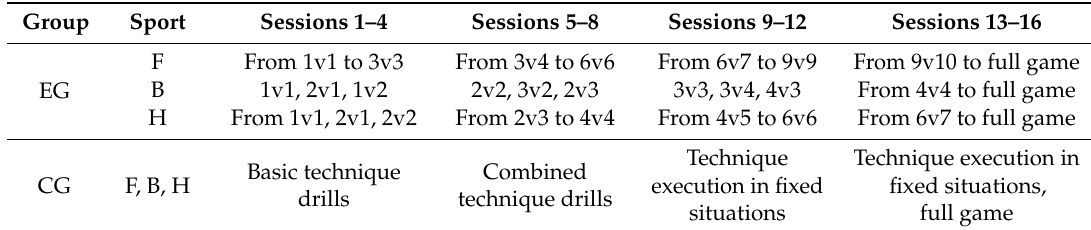
Table 2. Progression of activities per each sport